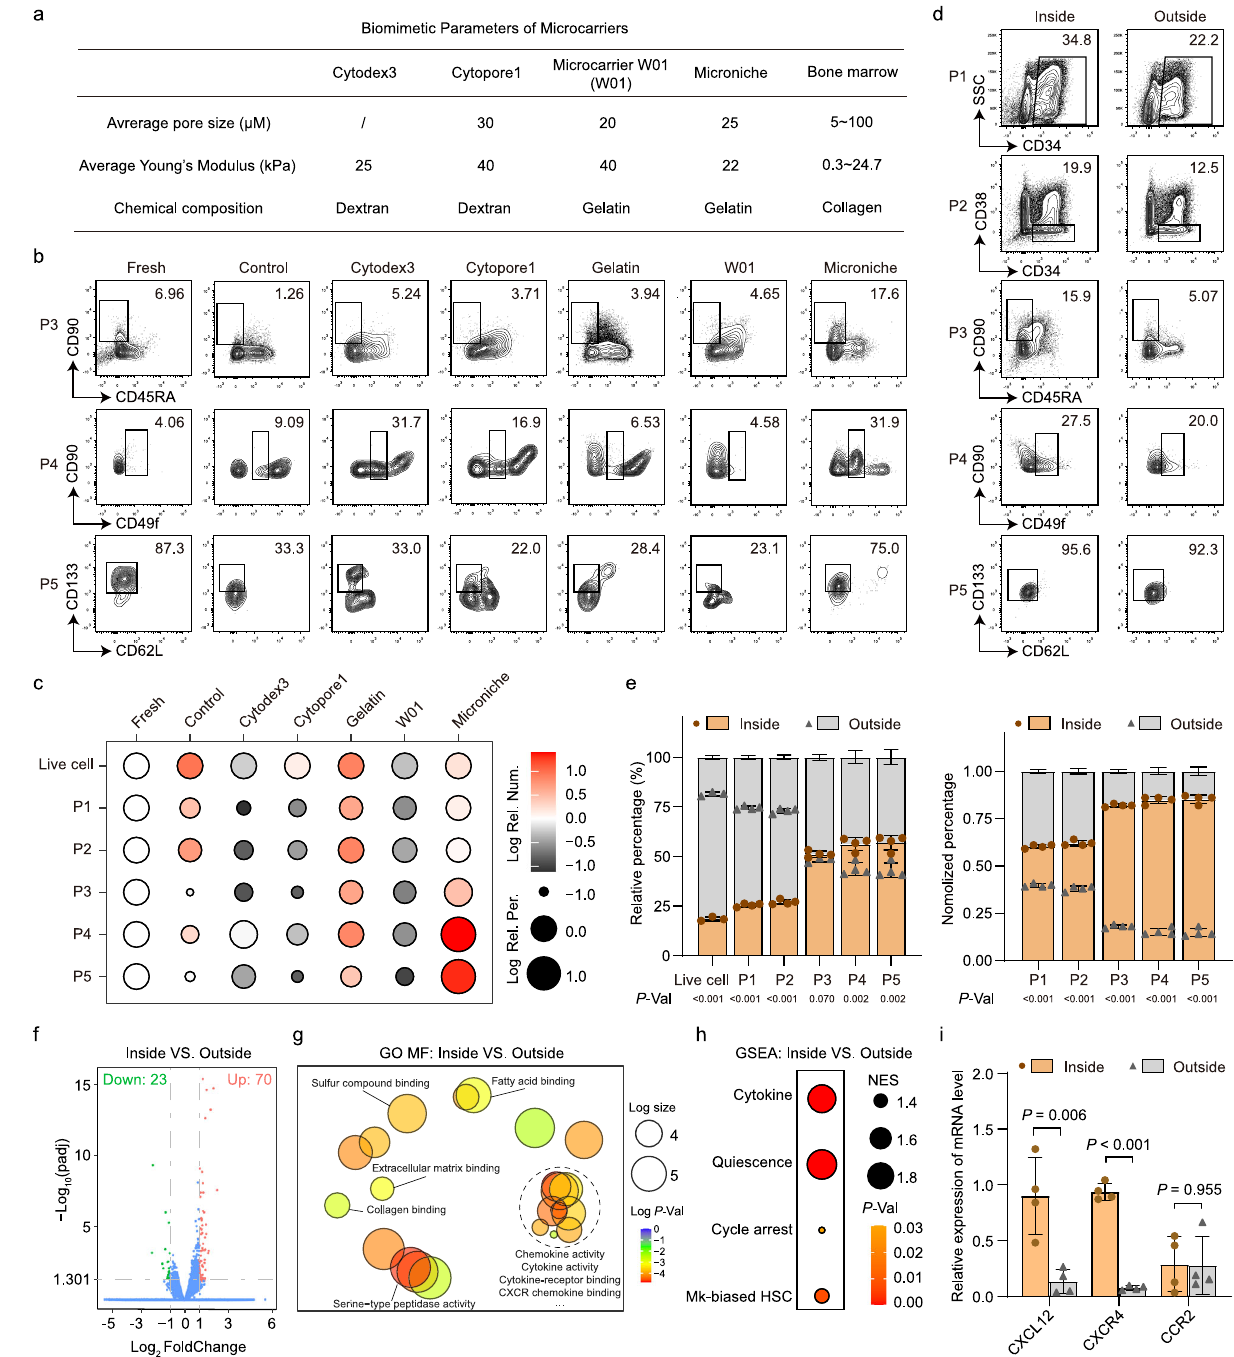
Fig.6|TheeffectofphysicalstructuretoexpansionofprimitiveandMk-biased HSCs.a Comparisonofbiomimeticparametersbetweendifferentbiomaterialsand bone marrow. b Representative FACS pro fi les of CD34 + CD38 − CD45RA − CD90 + (P3), CD34 + CD38 − CD45RA − CD90 + CD49f low (P4), and CD34 + CD38 − CD45RA − CD90 + CD49f low CD62L − CD133 + (P5) populations in UCB CD34 + cells before (fresh) and after culture in control medium or control medium supplemented with Cyto- dex3, Cytopore1, Gelatin, Microcarrier W01, or Microniche. Fresh, n =3 technical replicates; other groups, n =3 biological replicates. c Dot plot showing the Log absolute cell counts (color) and Log percentages (size) of phenotype-de fi ned cell subsetsrelativetothefreshcellgroupintheinvitrocultureassaysof( b ).Datawere normalized with data offresh group. d RepresentativeFACS pro fi les ofCD34 + (P1), CD34 + CD38 − (P2), P3, P4, and P5 populations inside or outside Microniche in cul- tured UCB CD34 + cells. e Relative percentage (left) and normalized percentage